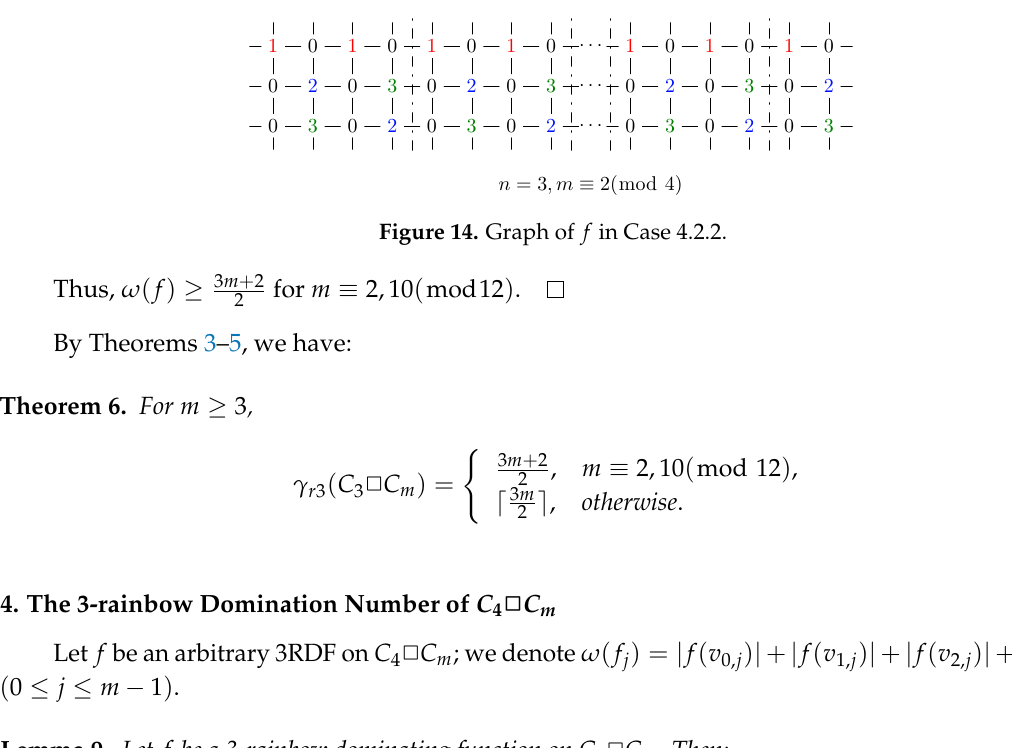
Figure 13. Graph of f in Case 4.2.1.